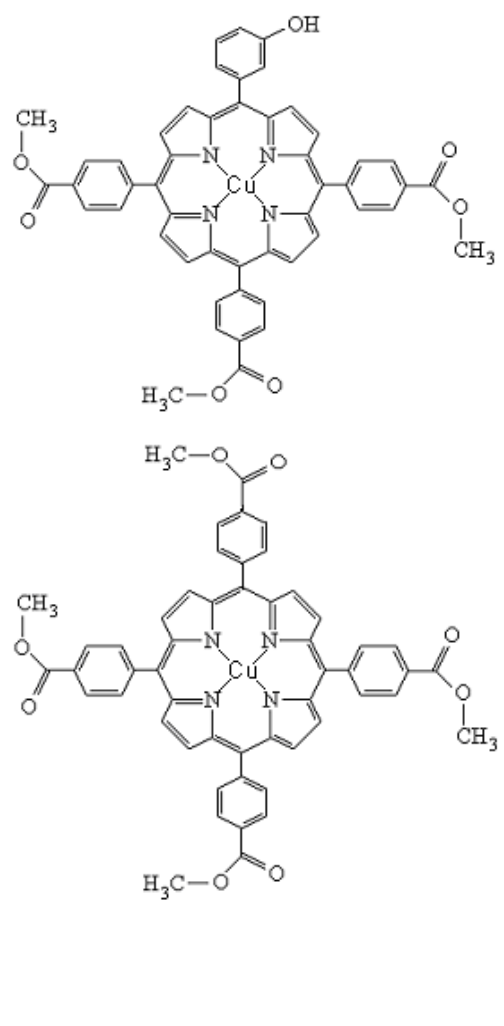
Figure 1. Structures of 5-(3-hydroxyphenyl)-10,15,20– tris -(4-carboxymethylphenyl)–21, 23 Cu(II) porphine (Cu(II)TCMOH ) (top) and 5,10,15,20- meso m